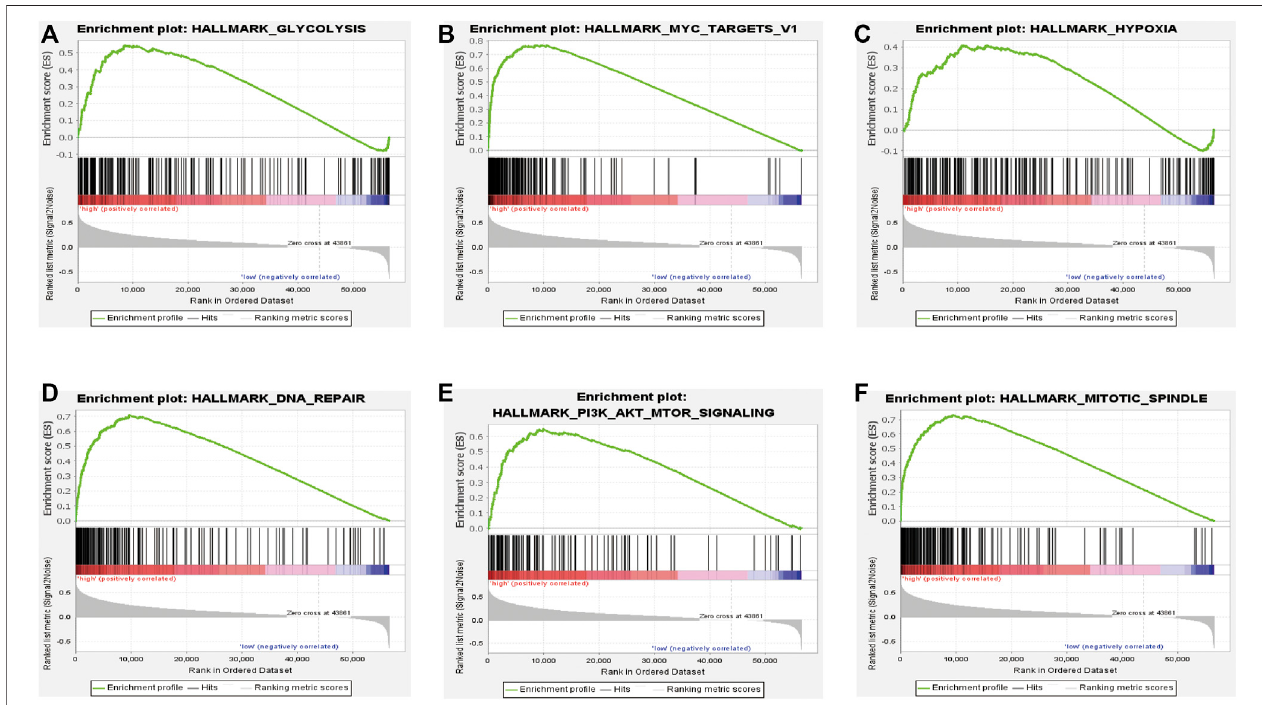
FIGURE 10 | Enrichment plots of the Gene Ontology annotation from GSEA. GSEA analysis showing (A) glycolysis, (B) Myc-targets, (C) hypoxia, (D) DNA repair, and (E) PI3K-AKT-MTOR signaling. (F) Mitotic spindles were closely correlated with the high-risk